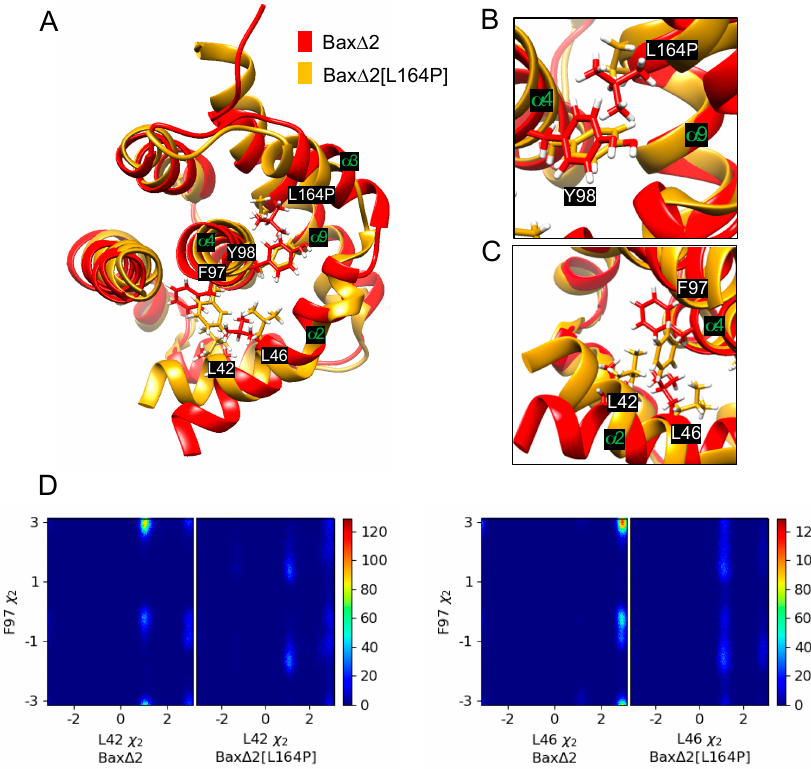
Figure 6. Analysis of dihedral angles. ( A ) Representative structures of Bax ∆ 2 and Bax ∆ 2[L164P]. Several helices and key amino acids of Bax ∆ 2 are labeled. ( B ) Closeup view of the L164P and Y98 region. ( C ) Closeup view of the F97, L42, and L46 region. ( D ) Two-dimensional histograms of dihedral angle pairs based on 200 ns of MD simulation: L42 χ 2 and F97 χ 2 ( left ), L46 χ 2 and F97 χ 2 ( right ).